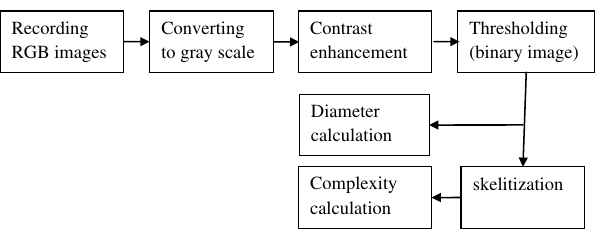
Fig. 7. Image processing and analysis °ow diagram.